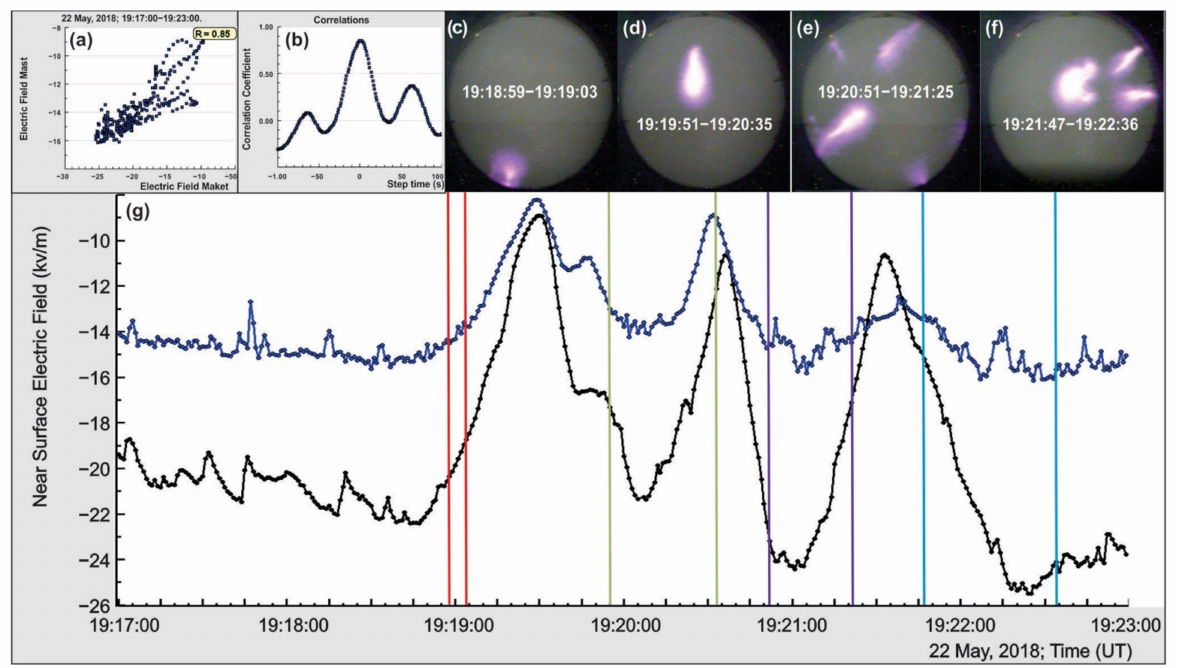
Figure 16. ( g ) 1s time series of NSEF disturbances measured by sensors located on the roof of MAKET building (black) and on the stand-alone 13 m high mast (blue). In the upper panel: ( a ) scatter plot of NSEF measurements, ( b ) the delayed correlations plot, ( c – f ) the patterns of registered light glows. Pairs of colored lines denote the times of registered glows correspondent to patterns portrayed above in frames ( c – f ).